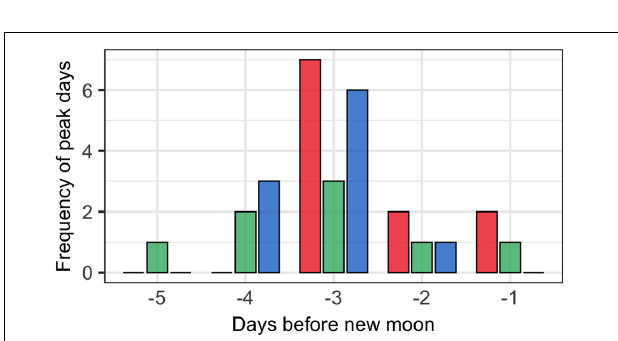
FIGURE 6 | Lunar day BNM with peak monthly abundance of fish numbers for groupers ( P. areolatus -red bars, E. polyphekadion -green bars, and E. fuscoguttatus - blue bars) for all surveyed months (2009, 2014, and